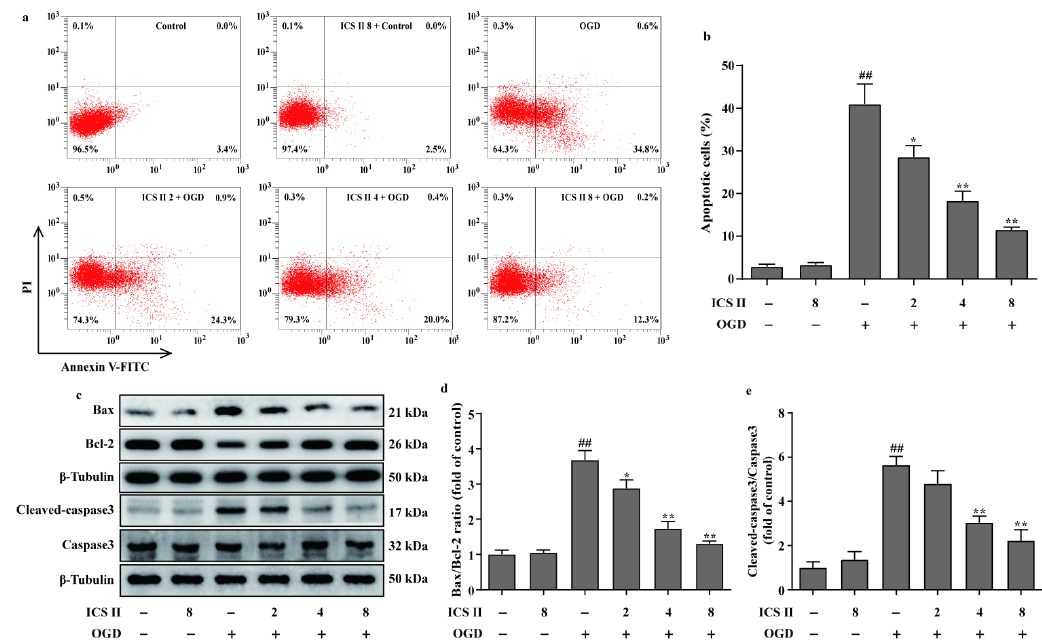
Figure 8. ICS II reduced OGD-induced cardiomyocyte apoptosis: ( a ) cardiomyocyte apoptosis was performed via flow cytometry; ( b ) quantitation of apoptotic percentage (%) ( n = 4); ( c ) representative Western blots of Bax and Bcl-2 expressions and representative Western blots of caspase3 and cleaved-caspase3 levels; ( d ) quantitation of Bax/Bcl-2 ratio ( n = 5); ( e ) quantitation of cleaved-caspase3/caspase3 ratio ( n = 5). The data are presented as the mean ± SEM. ## p < 0.01 vs. control; * p < 0.05, ** p < 0.01 vs. OGD.